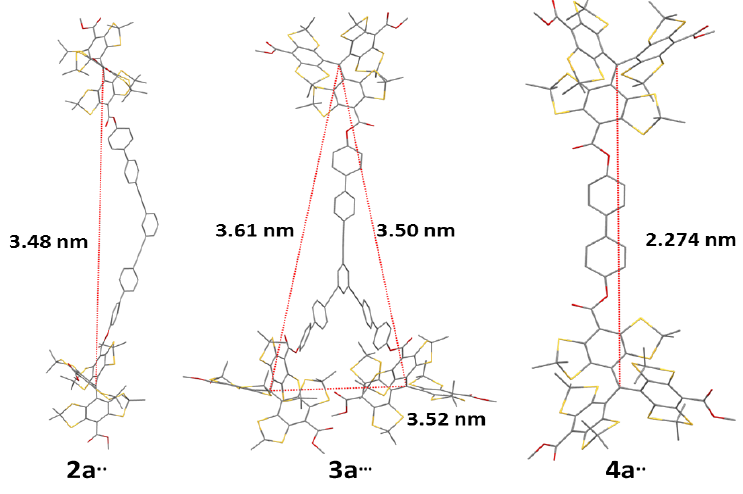
Figure 6. DFT optimized structures and inter-spin distances for compounds 2a •• , 3a ••• and 4a •• Table 2. Simulation parameters for the frozen solution EPR spectra (T = 120 K) of 1a • – 4b •• . Compound